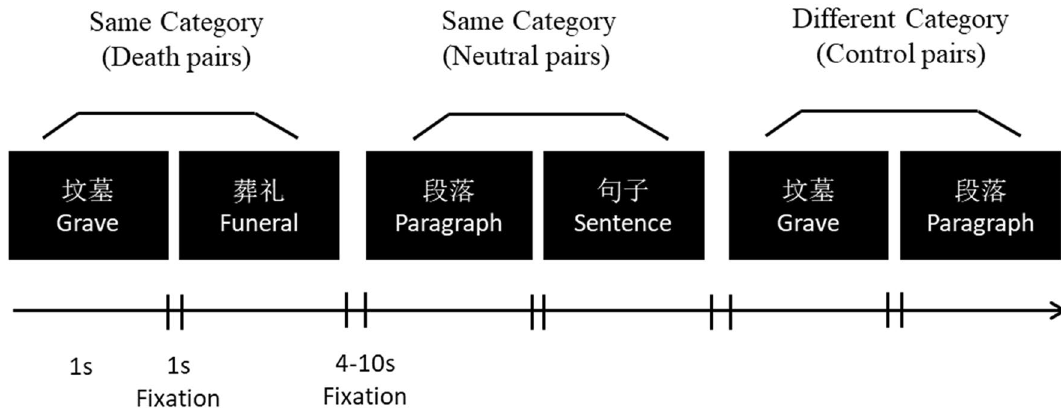
Figure 3. Word relationship task: participants judged as fast and accurately as they could whether two words presented in rapid succession belonged to the same